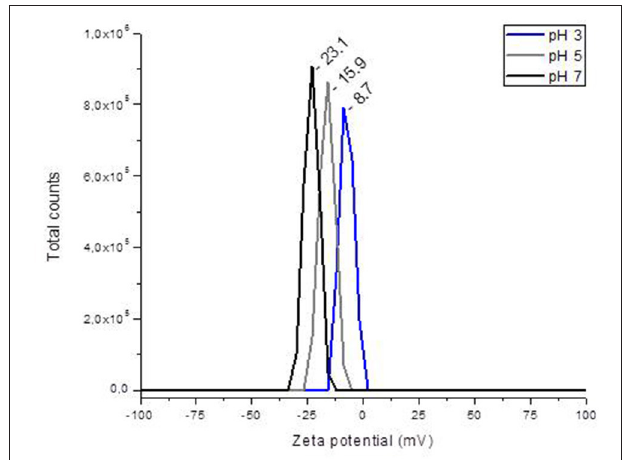
FIGURE 1 | The changes in zeta potential of the yeast cell wall fraction (YCW) with different